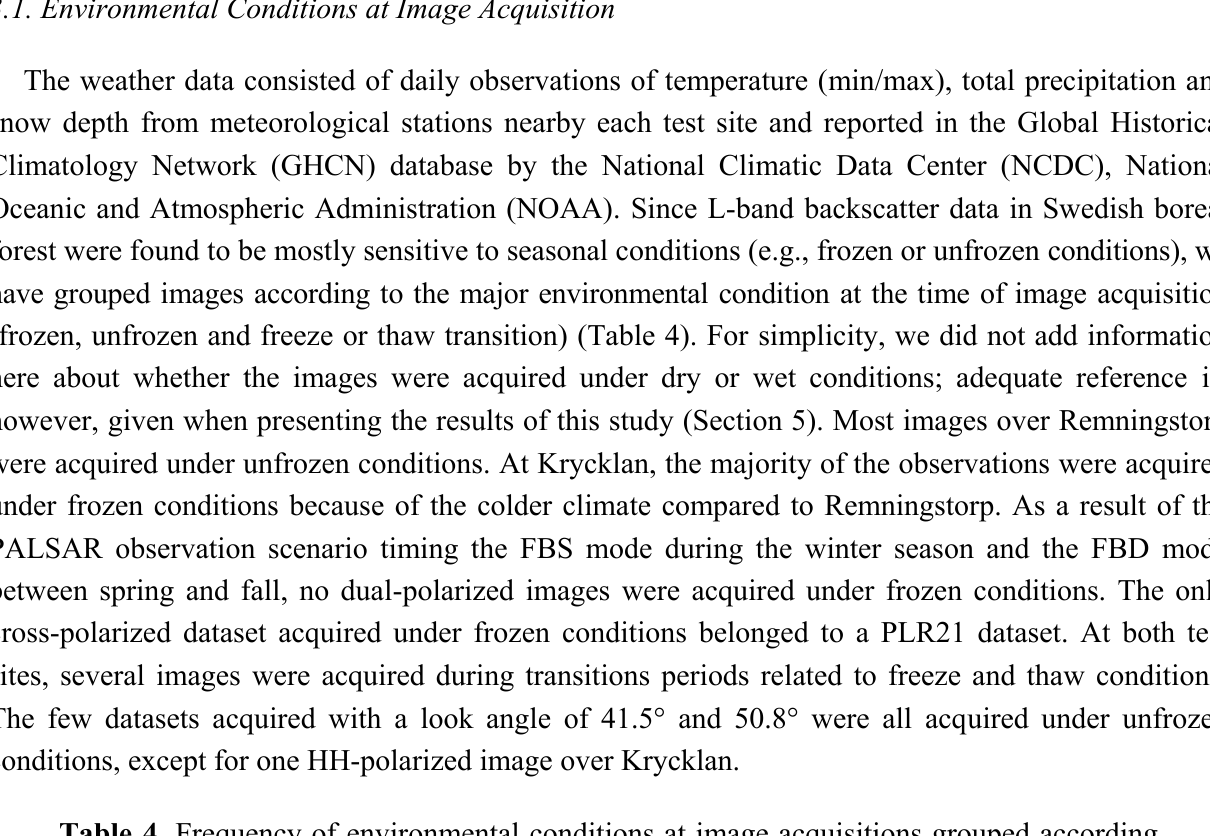
Table 4. Frequency of environmental conditions at image acquisitions grouped according to polarization and look angle for each test site (Re: Remningstorp; Kr: